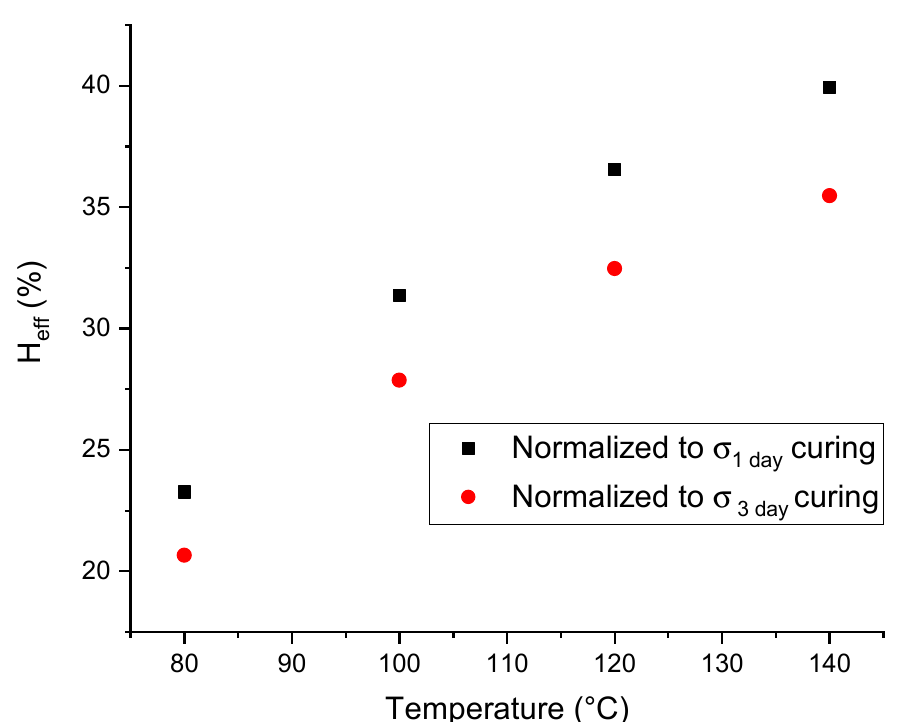
Figure 4. Temperature-dependency of healing efficiency. All measurements were performed after three days (the average standard deviation is SD σ 1 day = 6.67% and SD σ 3 day = 5.9%).